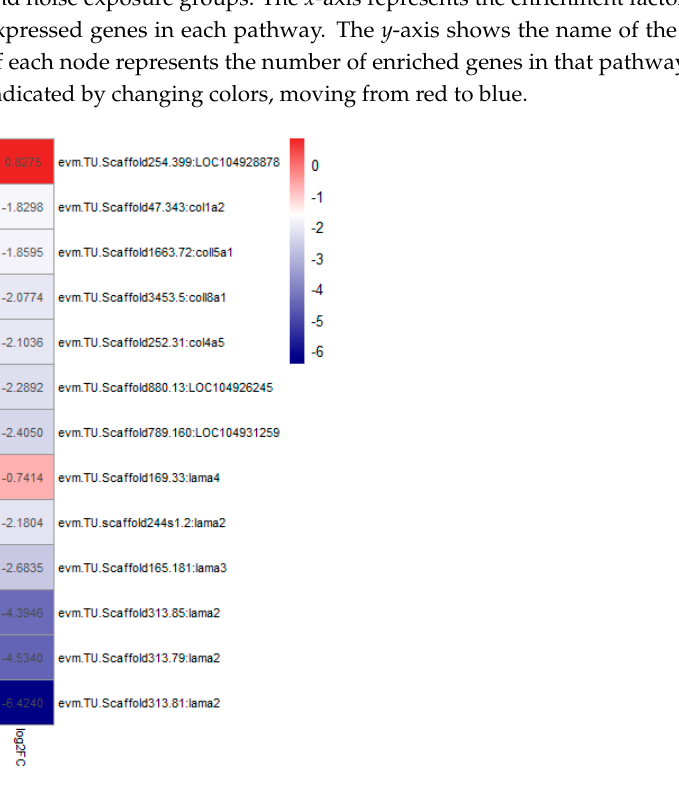
Figure 6. Heatmap showing the change in ECM-related genes (collage and laminin) after noise exposure. Log 2 FC: Fold change of the gene expression level in the exposure group compared with the control group. Red color in the heat map indicates up regulated genes and blue color indicates down regulated genes in the exposure group compared with the control group.